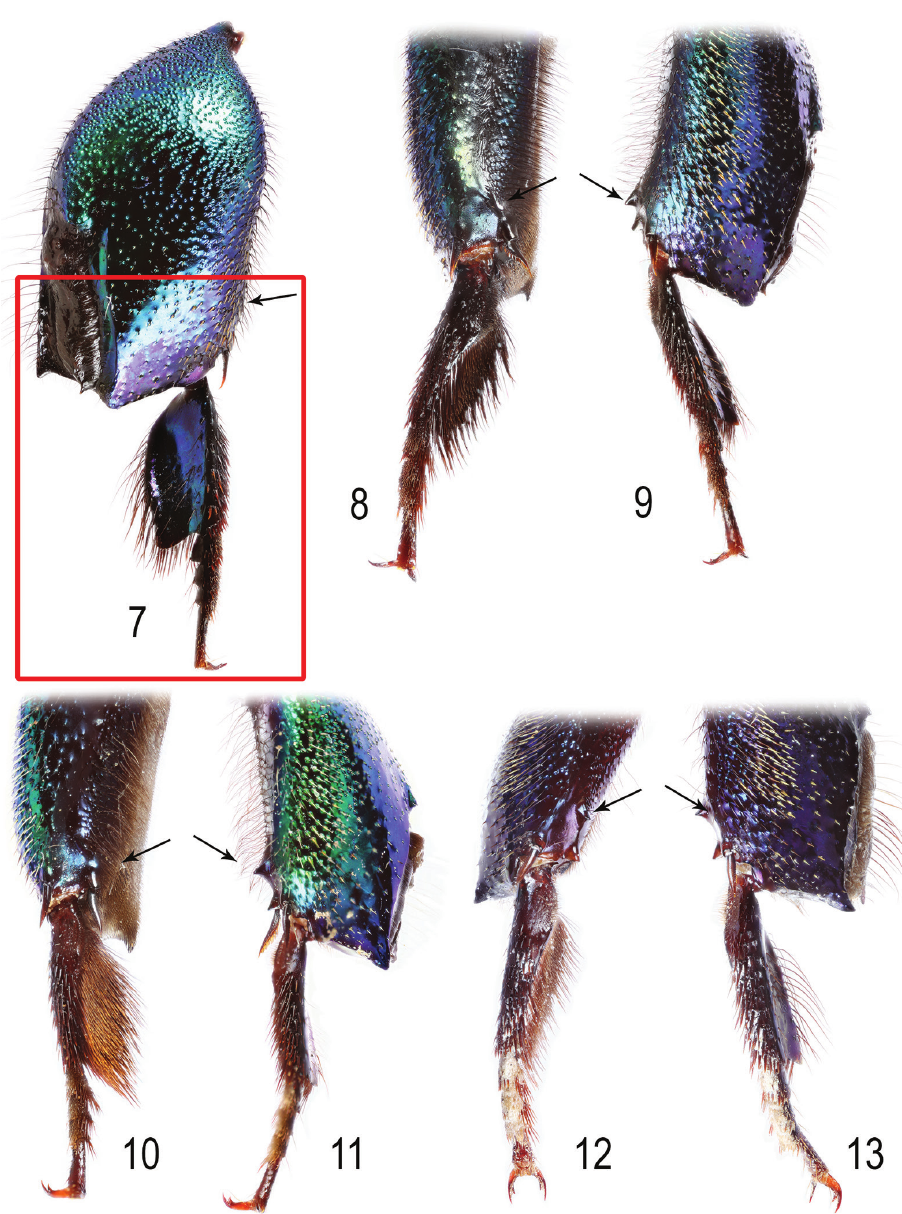
Figures 7–13. Outer view of the male hind leg ( 7 ) and detail of the subapical projection (indicated by an arrow) above the tibial spurs in anterior ( 8, 10, 12 ) and lateral views ( 9, 11, 13 ) Red box in Fig. 7 indi- cates detailed area in subsequent figures 7–9 E. coerulescens (Mexico: Nuevo León, ECO-TAP-E-104040) 10, 11 E. oliveri (paratype. Mexico: Guerrero, EMEC 1069134) 12, 13 E. simillima (paratype. Mexico: Chihuahua, KUNHM-ENT